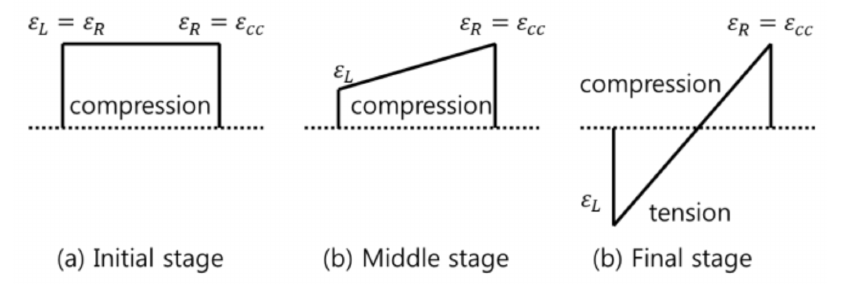
Figure 7. Stages of strain